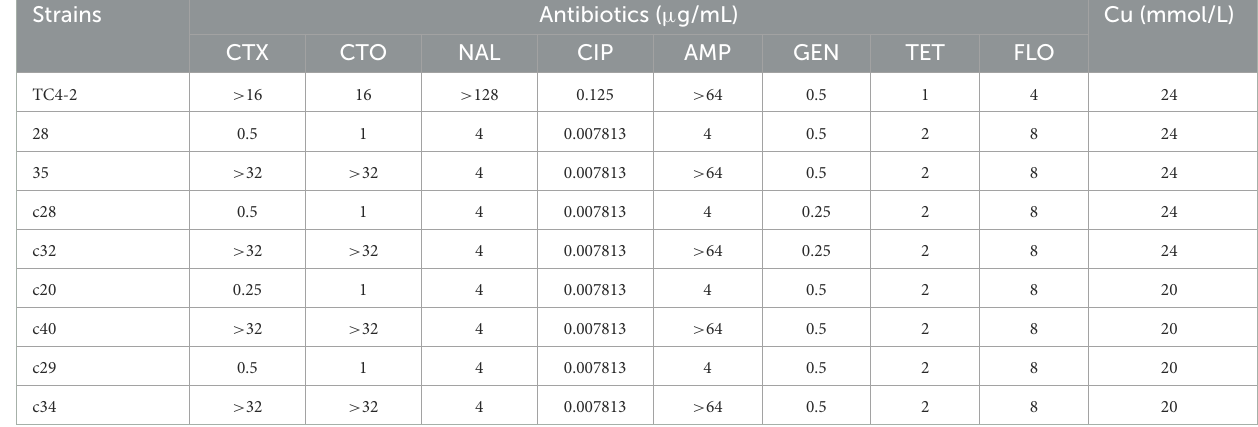
TABLE 6 Antibiotic and copper susceptibility of donor and recipient isolates, and the corresponding transconjugants.